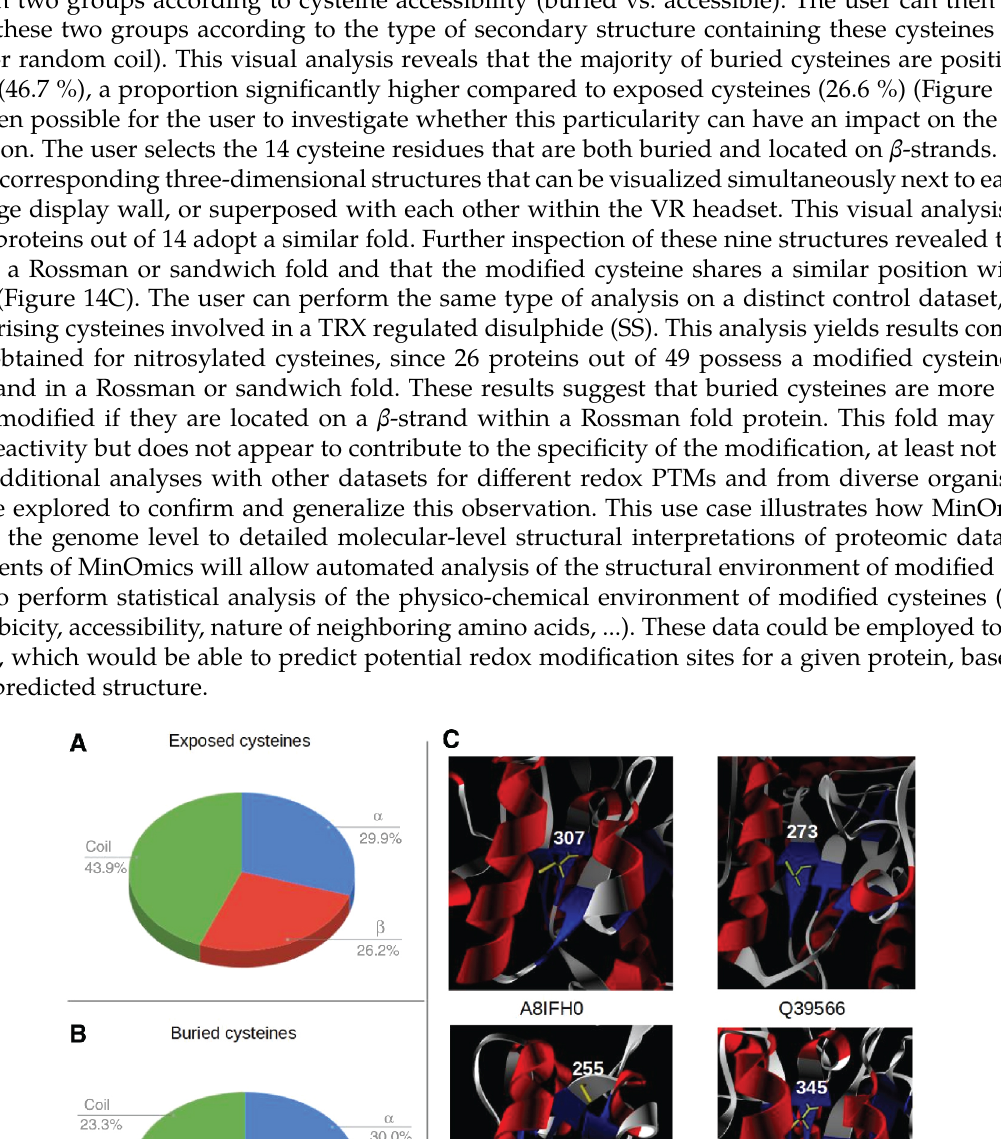
Figure 13: Navigation through MinOmics datasets. To illustrate navigation through datasets available in MinOmics, we investigate the subset of nitrosylated proteins. A combination of filtering clauses permits to i) focus on nitrosylated pro- teins (filter 0), ii) located on a β -sheet (filter 4), iii) with a cysteine and thiol buried inside the protein surface (filter 1 and 2) and iv) located on a Rossman-like fold (filter 11). This part is shown on the right half split-screen. The left half split- screen, a UnityMol stereoscopic view, allows to explore the molecular structures that were selected through the filtering process, here one of the proteins selected through the combined filters with highlighted cysteines.